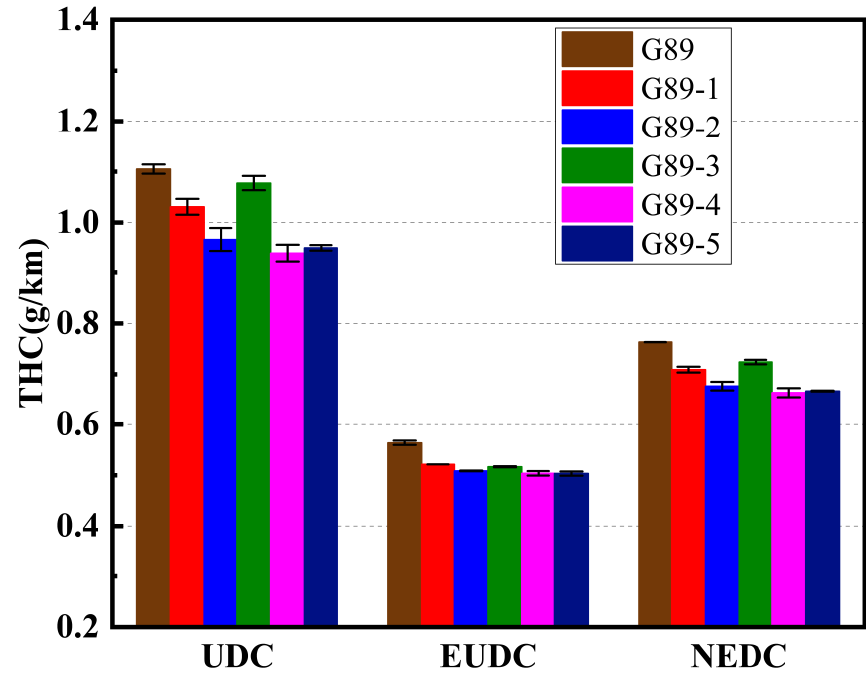
Figure 6. The THC emissions of the PFI vehicle when fueled with the different fuels.